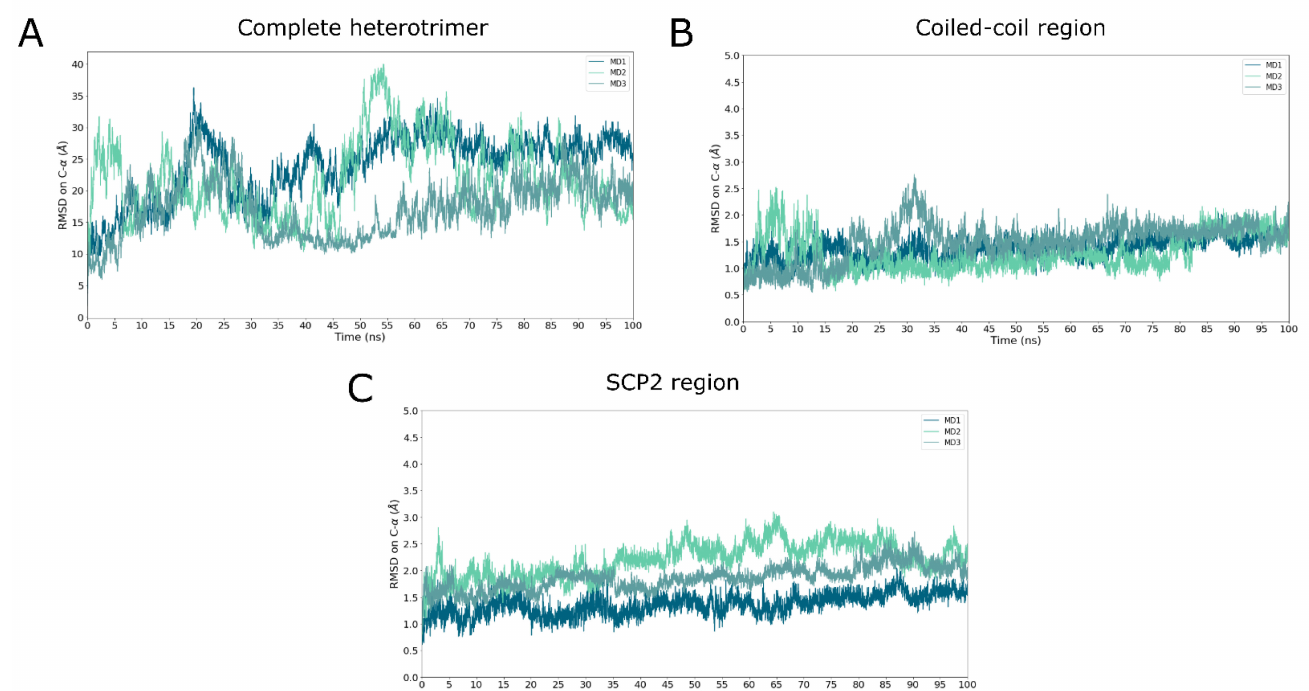
Figure 6. Heterotrimer stability in solution using all-atom MD simulation. C α -RMSD is plotted as a function of MD time (ns) for the whole system ( A ), only for the coiled-coil region ( B ) and for SCP2 domain ( C ). For ( A , B ), the RMSD fit was done on C α atoms of the coiled-coil region, which is defined by residues 171–201 for UbiJ and 49–85 for two chains of UbiK. For ( C ), the RMSD fit was done on SCP2 domain, defined by residues 1–121 of UbiJ. For all RMSD calculations, the first frame of each MD production was used as reference for RMSD